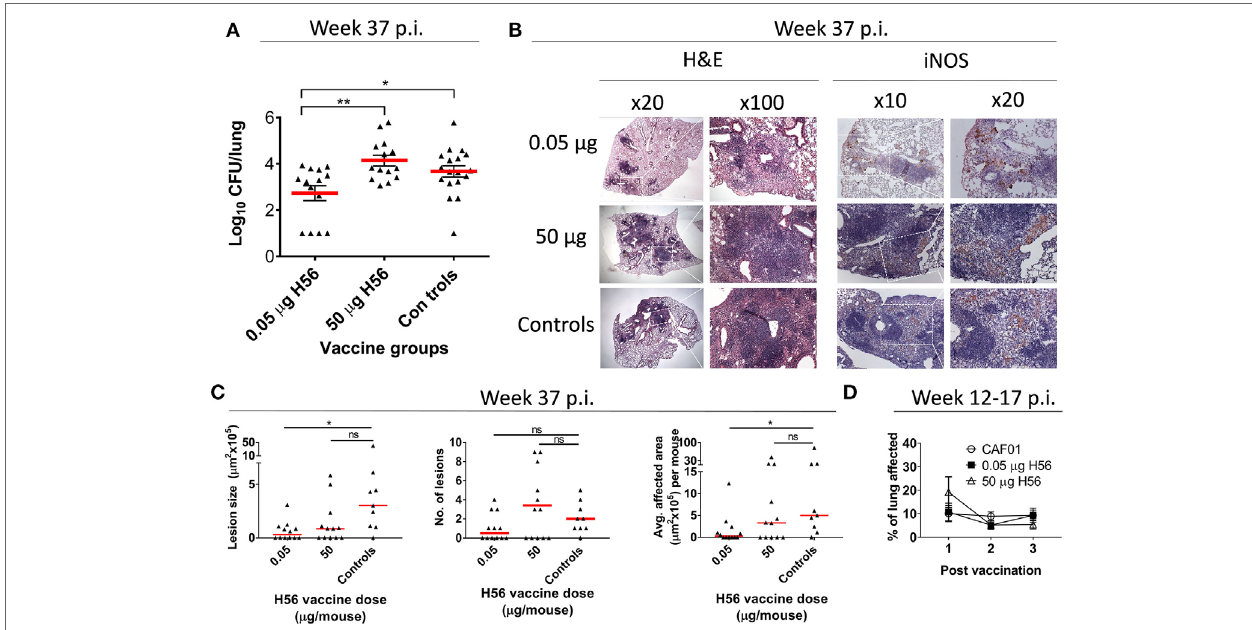
FigUre 2 | Low dose, but not high dose, H56 vaccination post-exposure reduces bacterial loads and lung pathology. (a) lung bacterial loads (log 10 CFU) 37 weeks after Mycobacterium tuberculosis challenge from mice vaccinated with the indicated dose of H56 in the post-exposure models. The histopathology data in (B,c) also derives from this experiment (Figure S1B in Supplementary Material, Exp#1). Symbols represent individual mice; lines represent mean ± SEM. (B) representative hematoxylin and eosin (H&E) stains (left panels) and inducible nitric oxide synthase (iNOS) immunohistochemistry (IHC; right panels) of lung tissue from the indicated vaccine groups. Regions of higher magnifications are indicated by inserts (dotted white lines) in lower magnification panels, with magnifications (20 × , 100 × ) indicated above panels. (c) The overall lesion size, number of lesions, and average area affected by tuberculosis inflammation per section are shown. Symbols represent individual mice; lines represent medians. * p < 0.05 by Kruskall–Wallis with Dunn’s posttest for multiple comparisons. (D) extent of lung inflammation 2 weeks after first and 1 week after second and third post-exposure vaccinations (corresponding to 12, 14, and 17 weeks p.i.) as assessed by H&E staining is shown in a separate experiment. Symbols represent mean ± SEM of n = 4–5 mice/group. Differences between vaccine groups were assessed using one-way ANOVA and Tukey’s posttest for multiple comparisons. Statistical significant differences are marked by asterisks, * p < 0.05, ** p < 0.01. These experiments were performed once